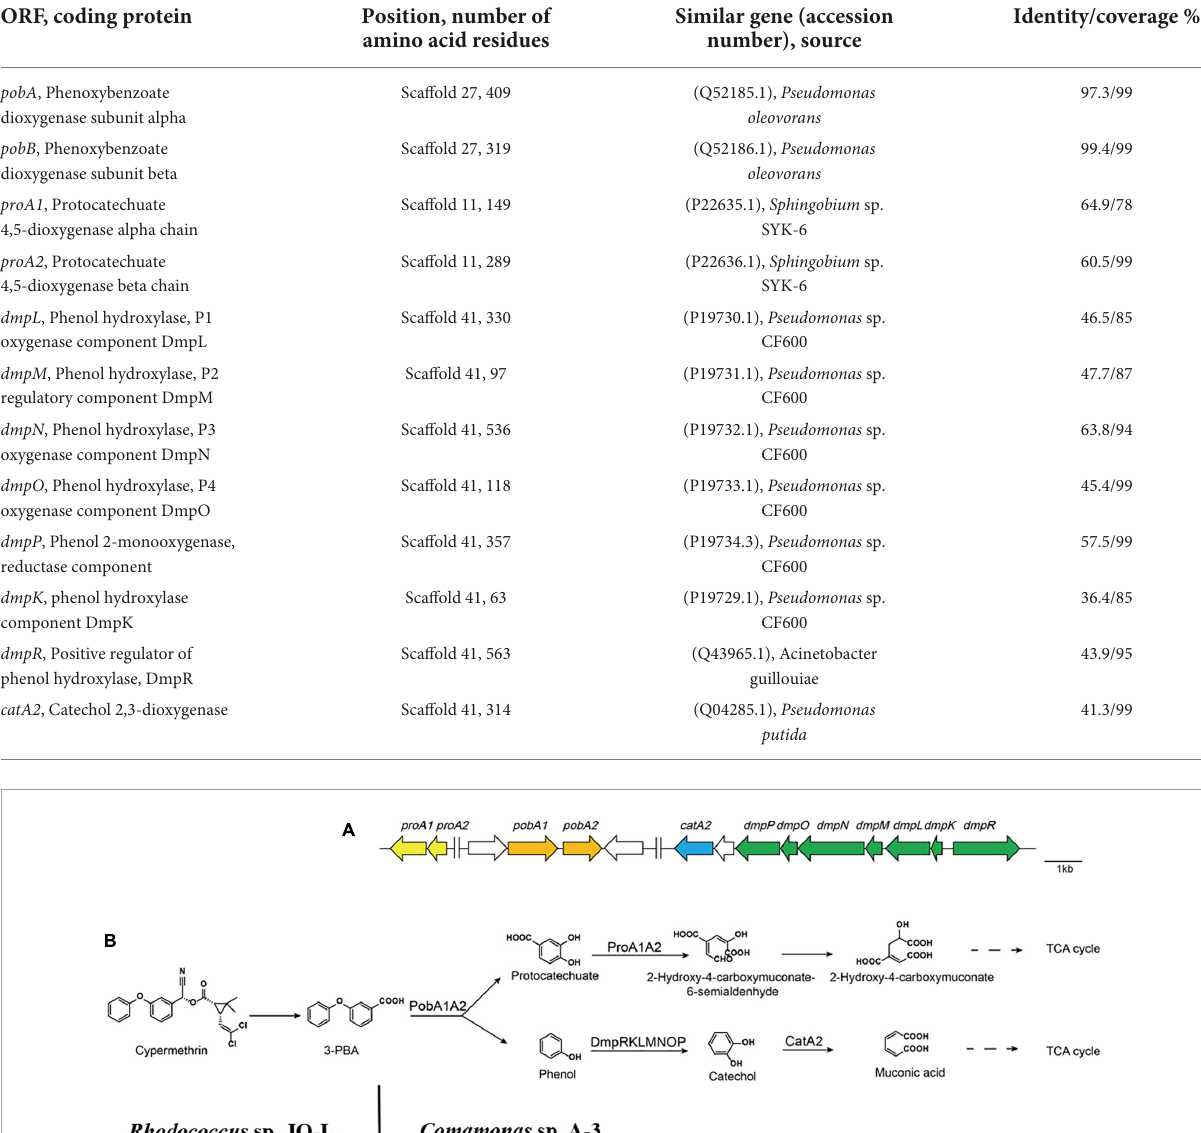
TABLE 1 Deduced function of each ORF that possibly involved in 3-PBA catabolism in the genome of A-3. ORF, coding protein Position, number of Similar gene (accession amino acid residues number), source